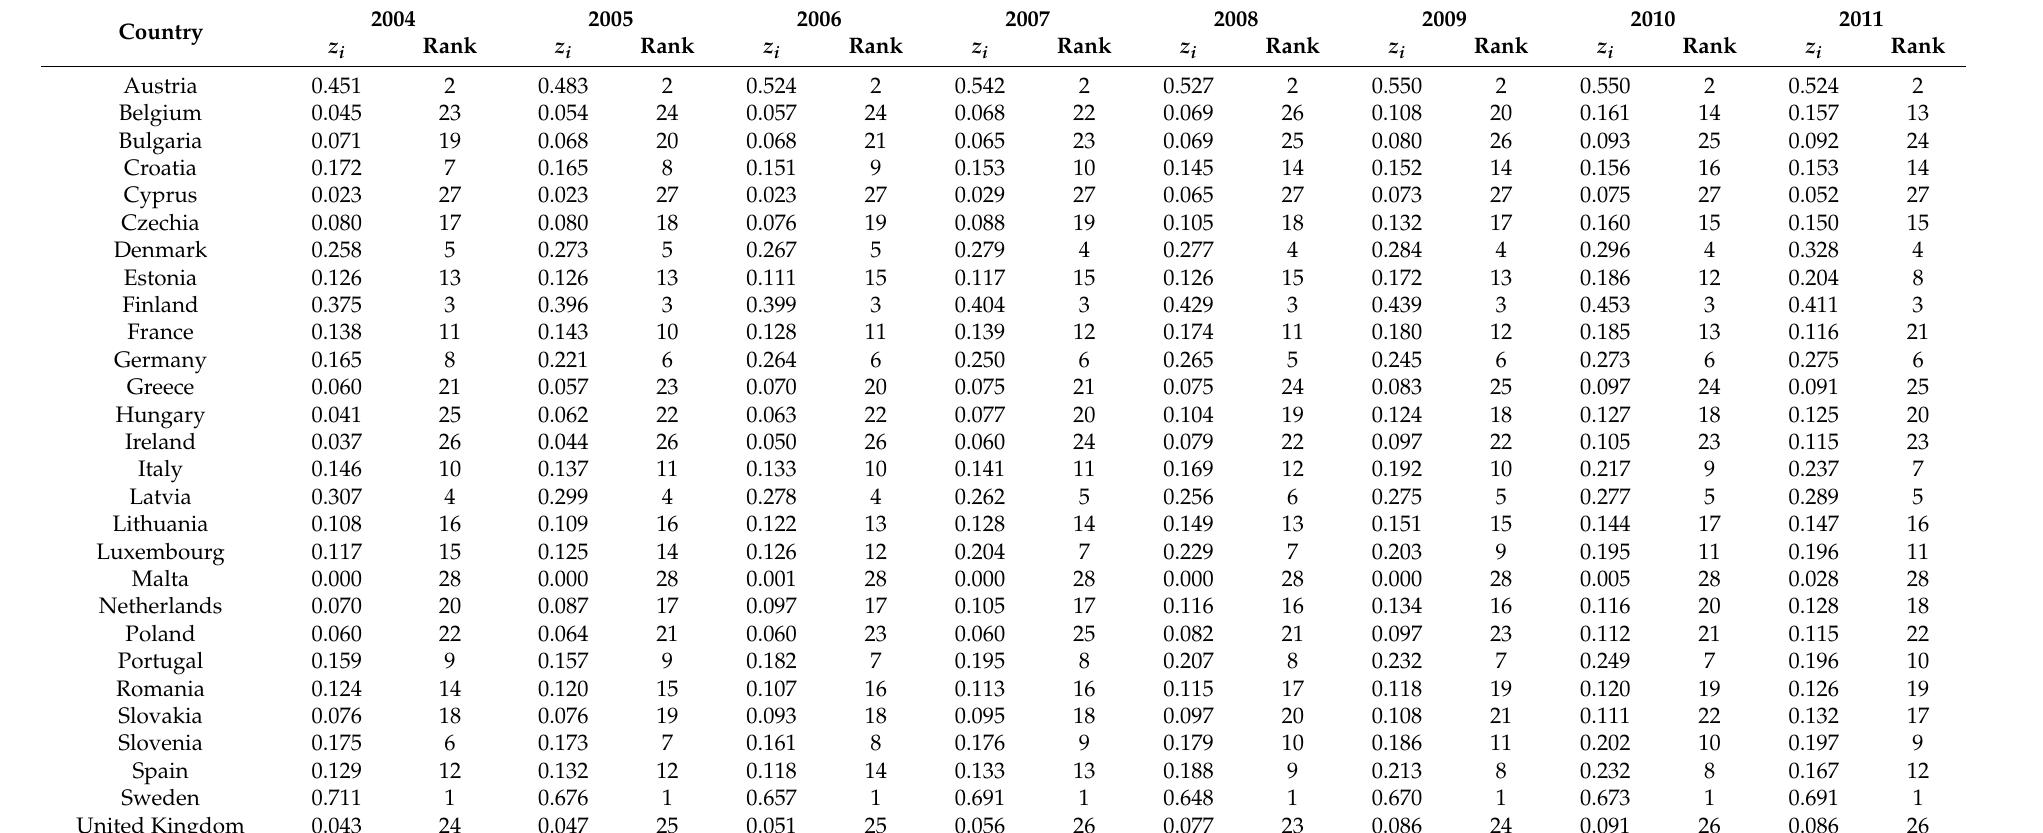
Table A1. The EU countries sorted by using renewable energy sources in: